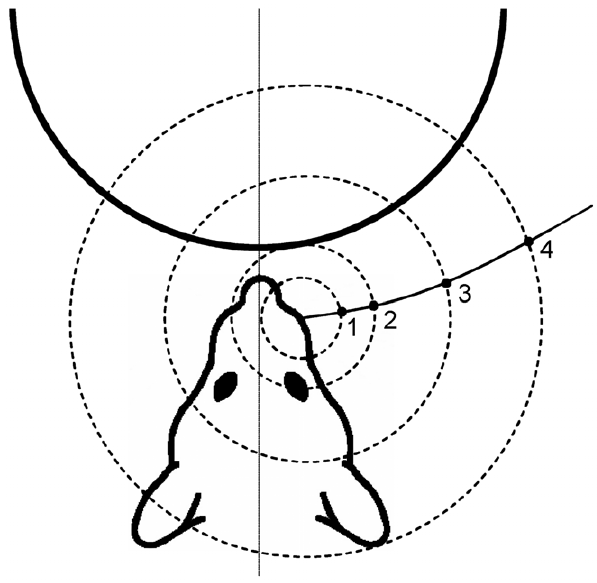
Figure 14. Simulation of whisker-object collisions. Circles are centered on the whisker base-point and constrain the movement of points on each whisker within a given rotation plane. Four locations along the whisker are indicated as black dots. The object (a cylinder) is indicated as a heavy black line. Only one whisker is shown and its length has been exaggerated for visual